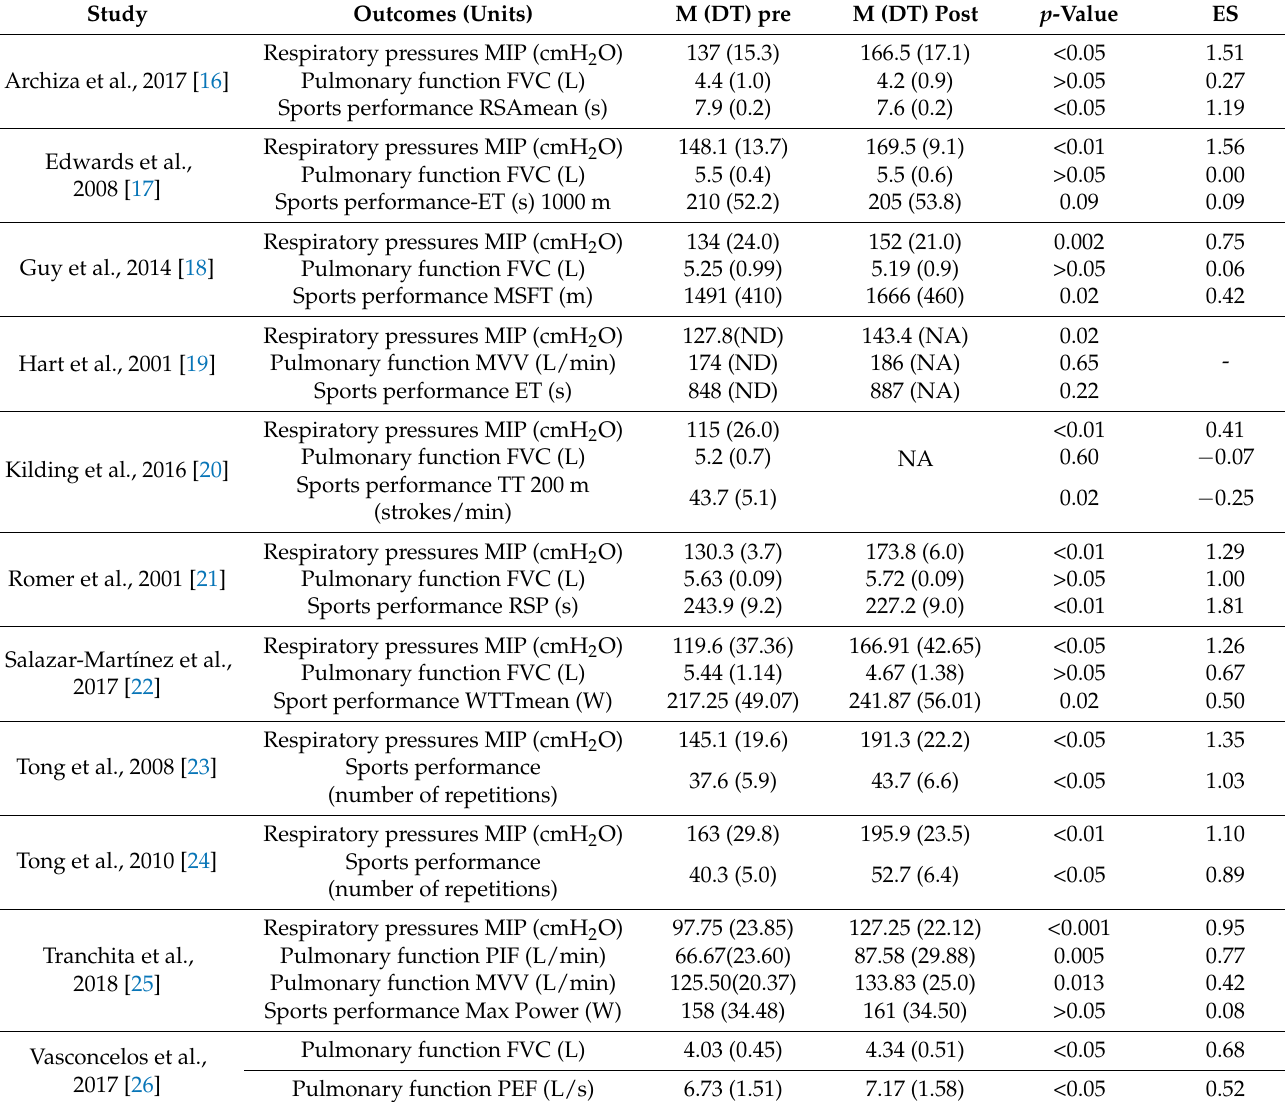
Table 7. Calculation of effect si’e by Rosenthal’s